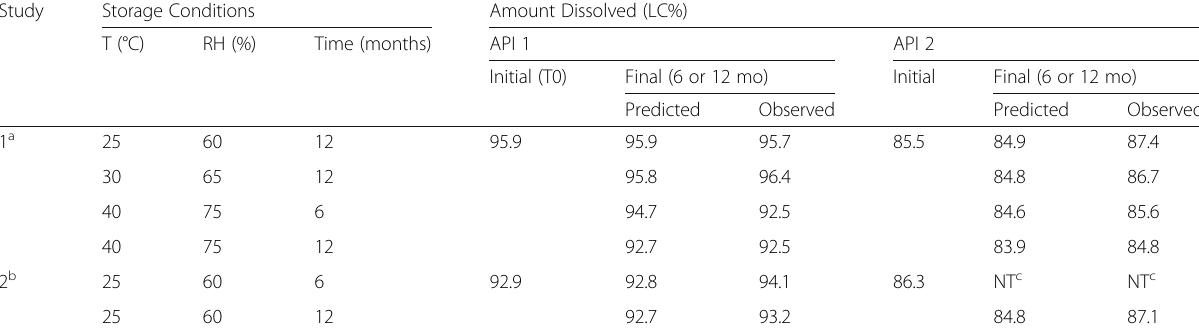
Table 5 Predicted and observed dissolution of the two active pharmaceutical ingredients after 20 min at different storage conditions of temperature (T) and relative humidity (RH)